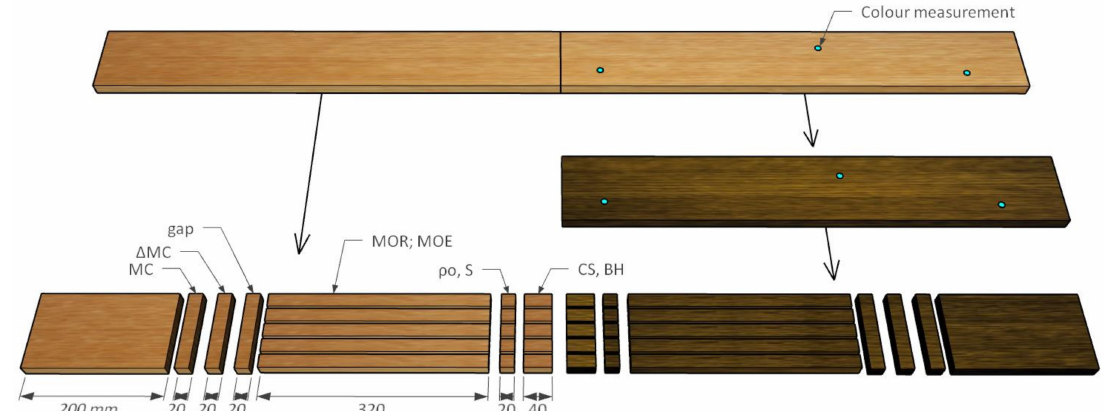
Figure 1. Sampling of unmodified and modified boards.